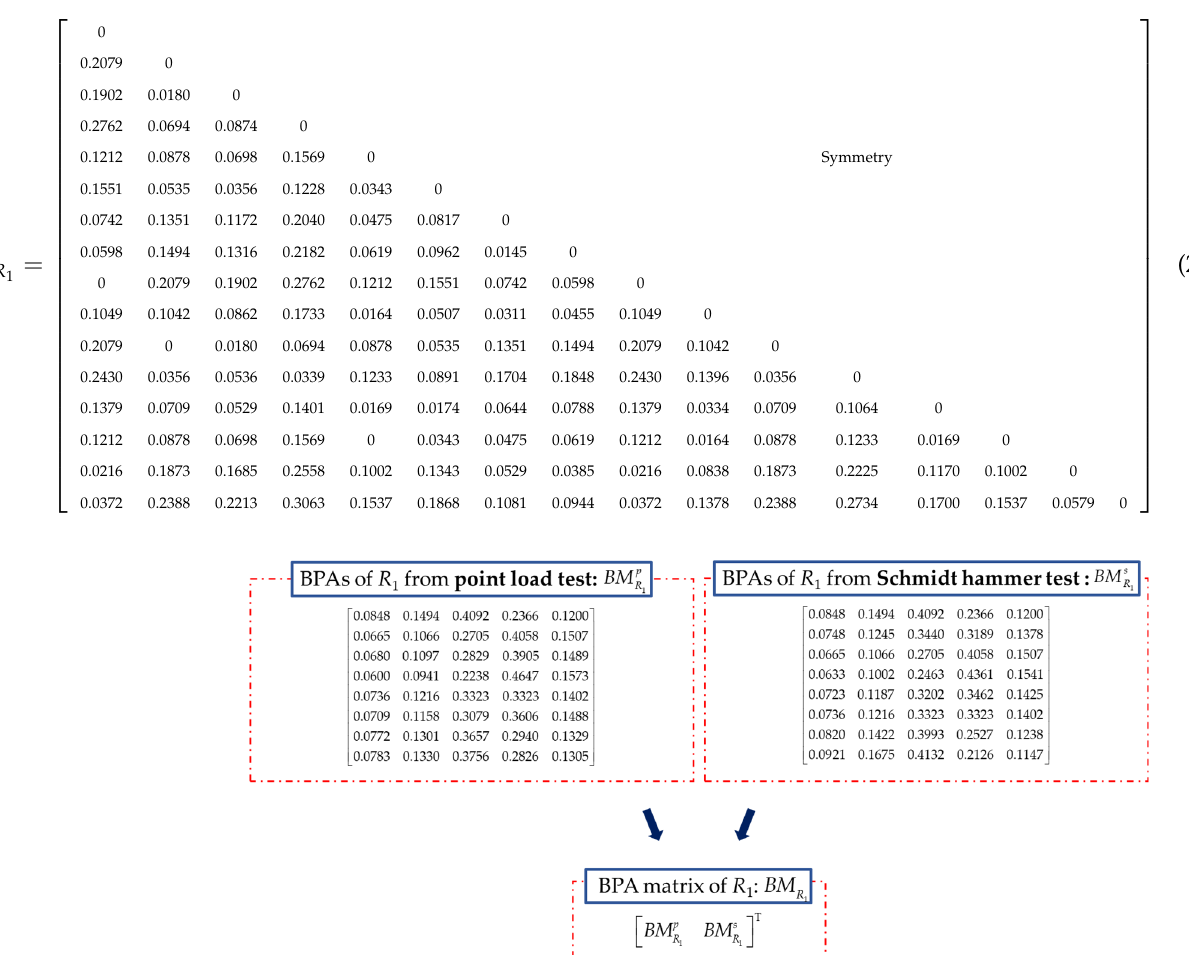
Figure 7. Constructed with BPAs of R 1 .